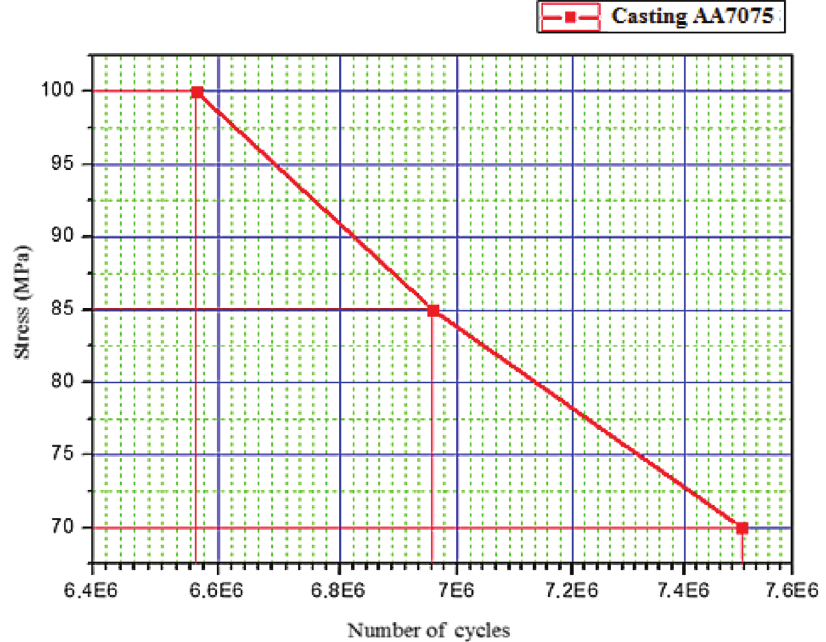
Figure 6: S – N curve of casting of AA7075